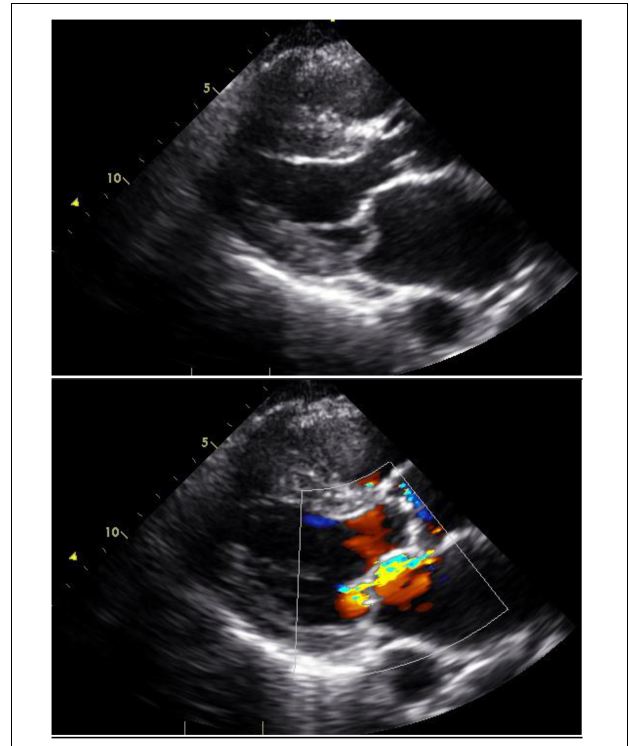
FIGURE 3 | Mitral valve prolapse: Still images with and without color Doppler in a woman with mitral valve prolapse affecting the posterior leaflet. The posterior leaflet bows beyond the mitral annular plane and produces an anteriorly-directed jet of mitral regurgitation.